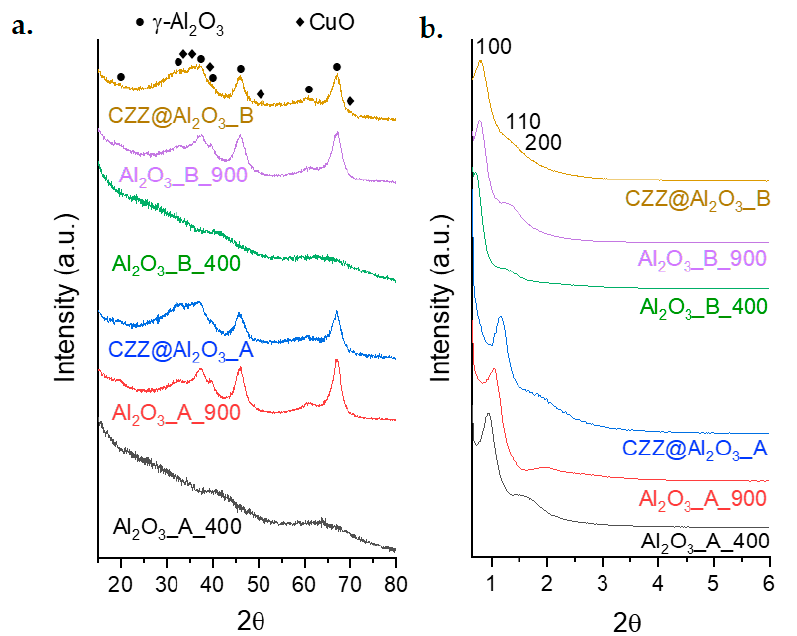
Figure 1. Wide-angle ( a ) and small-angle ( b ) X-ray diffraction patterns of the samples Al 2 O 3 _A (from P123) and Al 2 O 3 _B (from F127). P123) and Al 2 O 3 _B (from